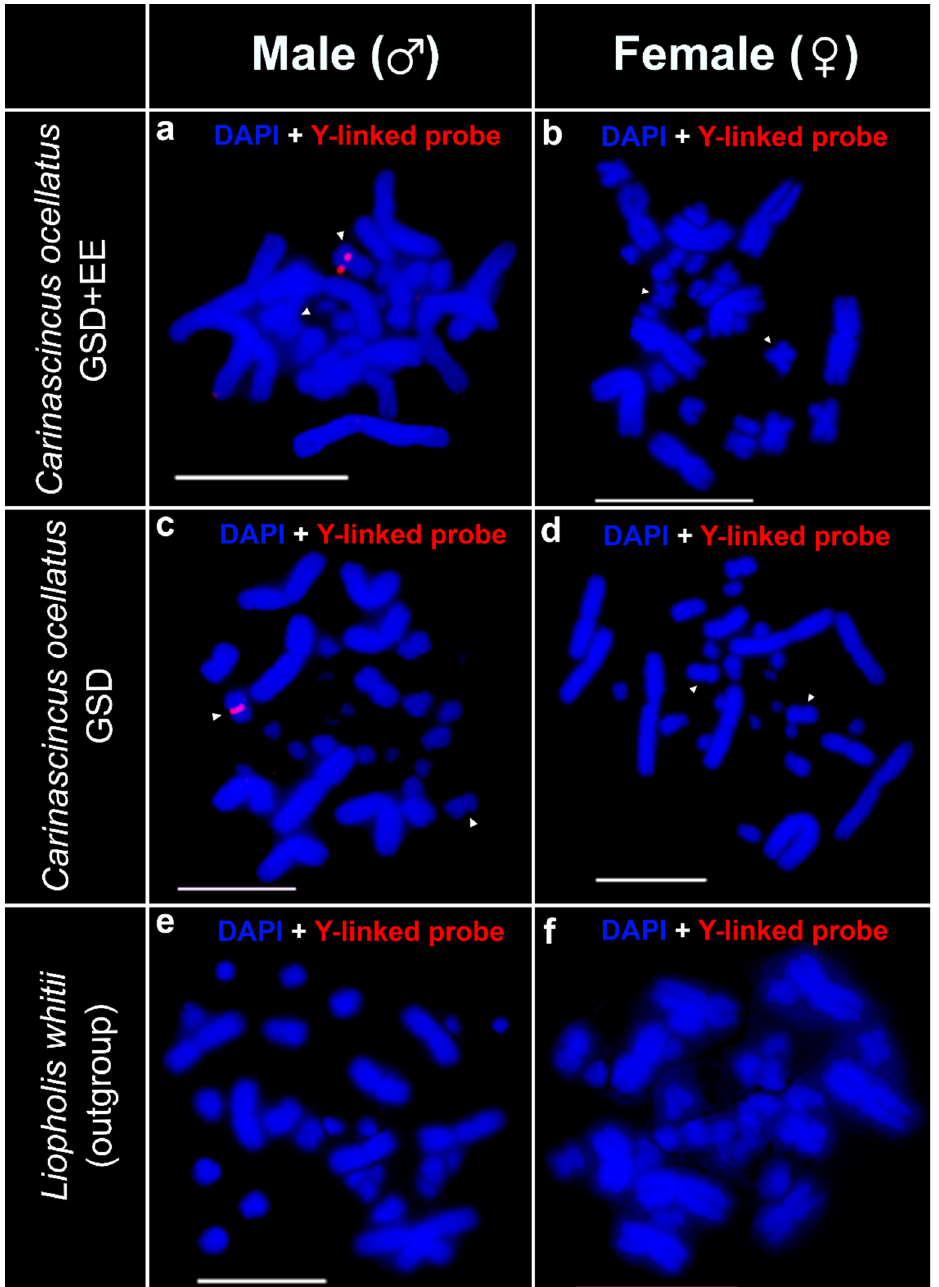
Figure 4. Chromosomal locations of Carinascincus ocellatus Y-linked FISH probe set (red) in GSD+EE (low elevation) C. ocellatus male ( a ) and female ( b ), GSD (high elevation) C. ocellatus male ( c ) and female ( d ), and Liopholis whitii male ( e ) and female ( f ). White arrowhead indicates X and Y (the homologous pair) chromosomes in C. ocellatus . Scale bar represents 10 µm.